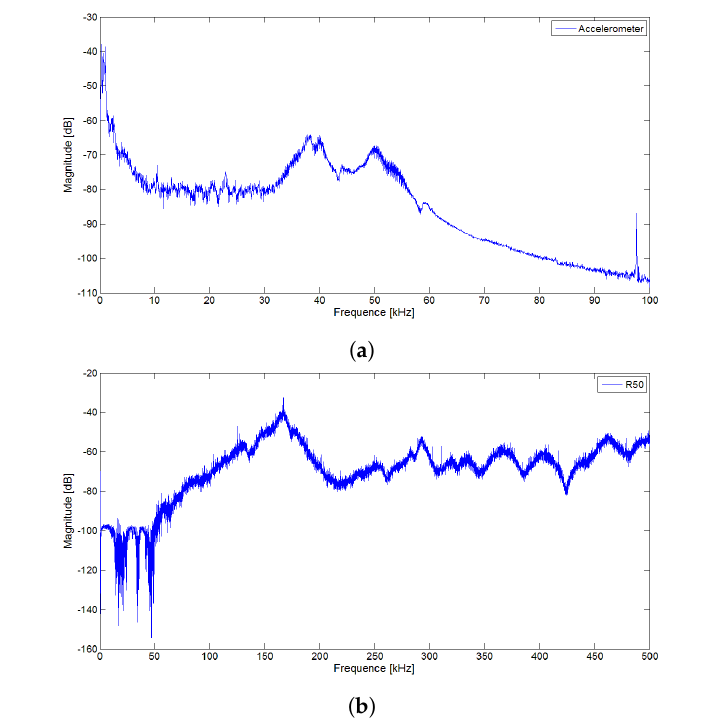
Figure 4. Transducer transfer function: ( a ) accelerometer and ( b ) ultrasound